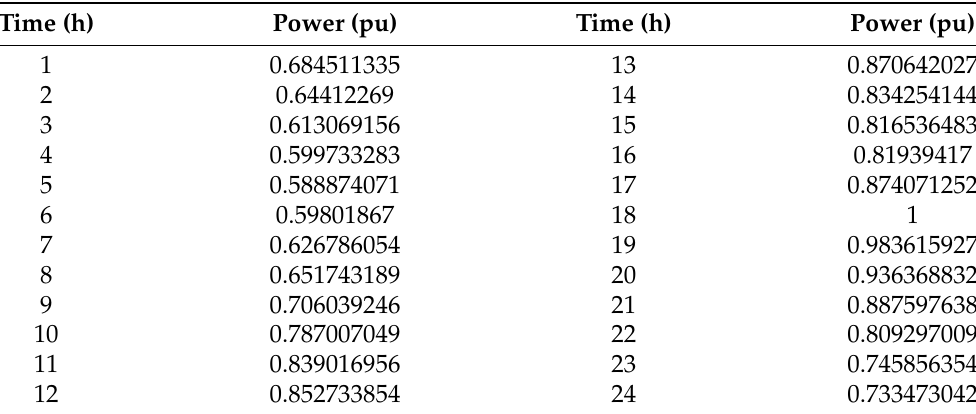
Table 10. Data for the typical load curve in the S 3.